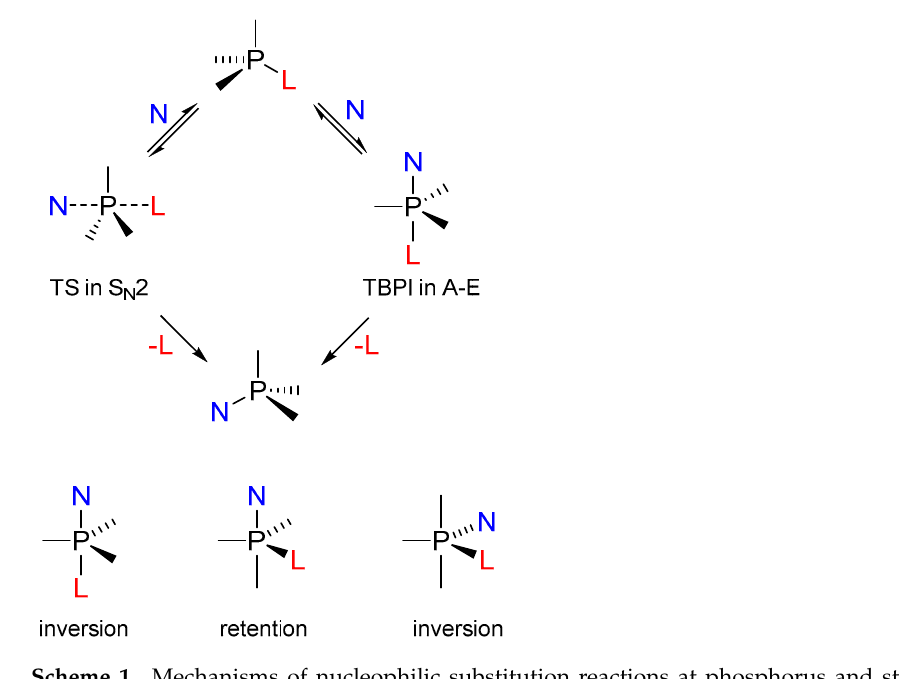
Scheme 1. Mechanisms of nucleophilic substitution reactions at phosphorus and structures of